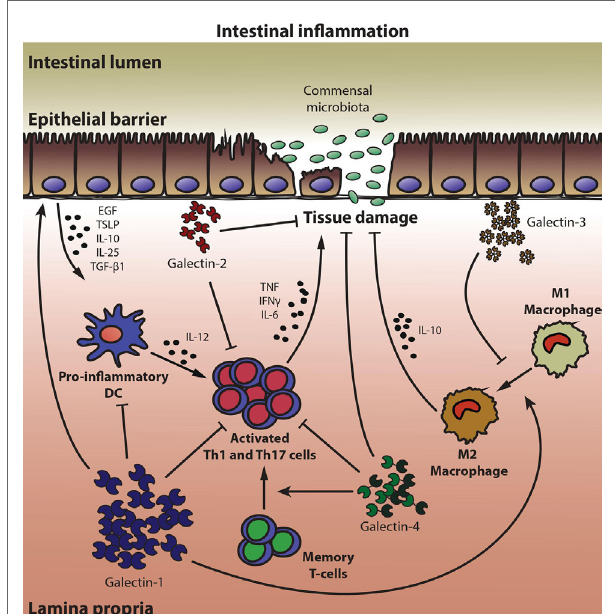
FiGUre 1 | Multifunctional roles of galectins in mucosal intestinal inflammation. A coordinated network of galectin family members, which exerts either anti-inflammatory or proinflammatory responses, conditions epithelial barrier maintenance and immune gut homeostasis. Galectin-1 (Gal-1) promotes the secretion of growth factors and anti-inflammatory cytokines by epithelial cells (ECs), induces apoptosis of activated Th1 and Th17 cells, inhibits secretion of proinflammatory cytokines by dendritic cells (DCs) and T lymphocytes, and favors an anti-inflammatory (M2) macrophage phenotype. Similar to Gal-1, Gal-2 displays several anti-inflammatory properties, but also promotes wound healing and tissue regeneration in ECs. In animal models of colitis, Gal-3 shows mostly proinflammatory functions, inhibiting the polarization of macrophages toward an M2 phenotype, whereas Gal-4 exhibits both anti- and proinflammatory properties within the intestinal inflamed mucosa, depending on the experimental setting analyzed. By blocking production of proinflammatory cytokines, Gal-4 prevented inflammation and favored epithelial regeneration. However, through binding to memory T-cells, Gal-4 led to T-cell activation and perpetuated intestinal inflammation.